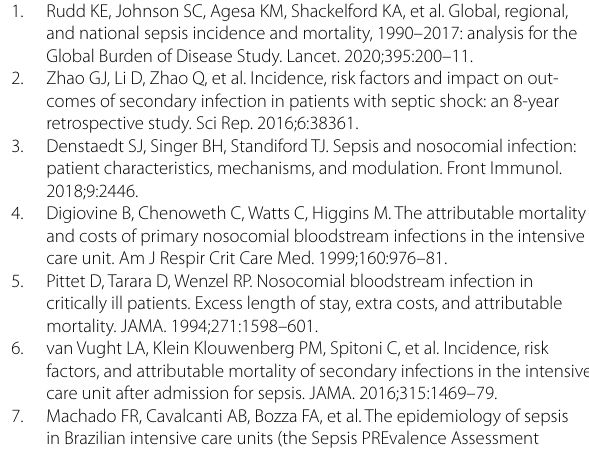
dysfunction at presentation for the second alternative definition analysis. Figure S9 . Distribution of odds ratio (upper row) and PAF (lower row) according to admission type (columns) for the second alternative defini‑ tion considering the effects of definitive and very probably sepsis. Figure S10 . Distribution of odds ratio (upper row) and PAF (lower row) according to admission type (columns) for the post hoc definition based on SOFA score. Figure S11 . Distribution of odds ratio (upper row) and PAF (lower row) according to admission type (columns) after excluding patients with infection at baseline. Figure S12. Comparison of the three definitions for elective surgery admissions. Upper panel: The daily odds ratio for mortality in elective surgery patients according to the definition used. Bottom panel: The respective AF for each definition. Note that a higher OR does not equal higher AF since prevalence of events also changes. Figure S13 . Comparison of the three definitions for emergency surgery admissions. Upper panel: The daily odds ratio for mortality in medical patients accord‑ ing to the definition used. Bottom panel: The respective AF for each defini‑ tion. Note that a higher OR does not equal higher AF since prevalence of events also